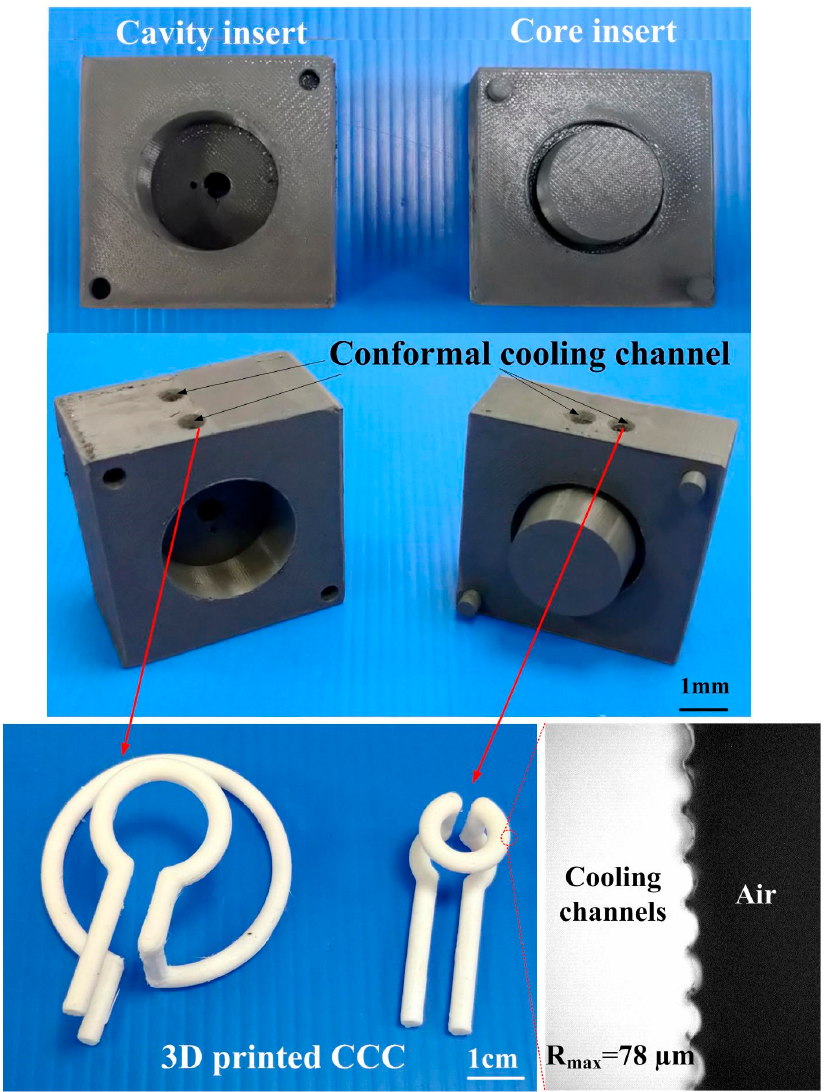
Figure 18. SRM made with recipe 4.